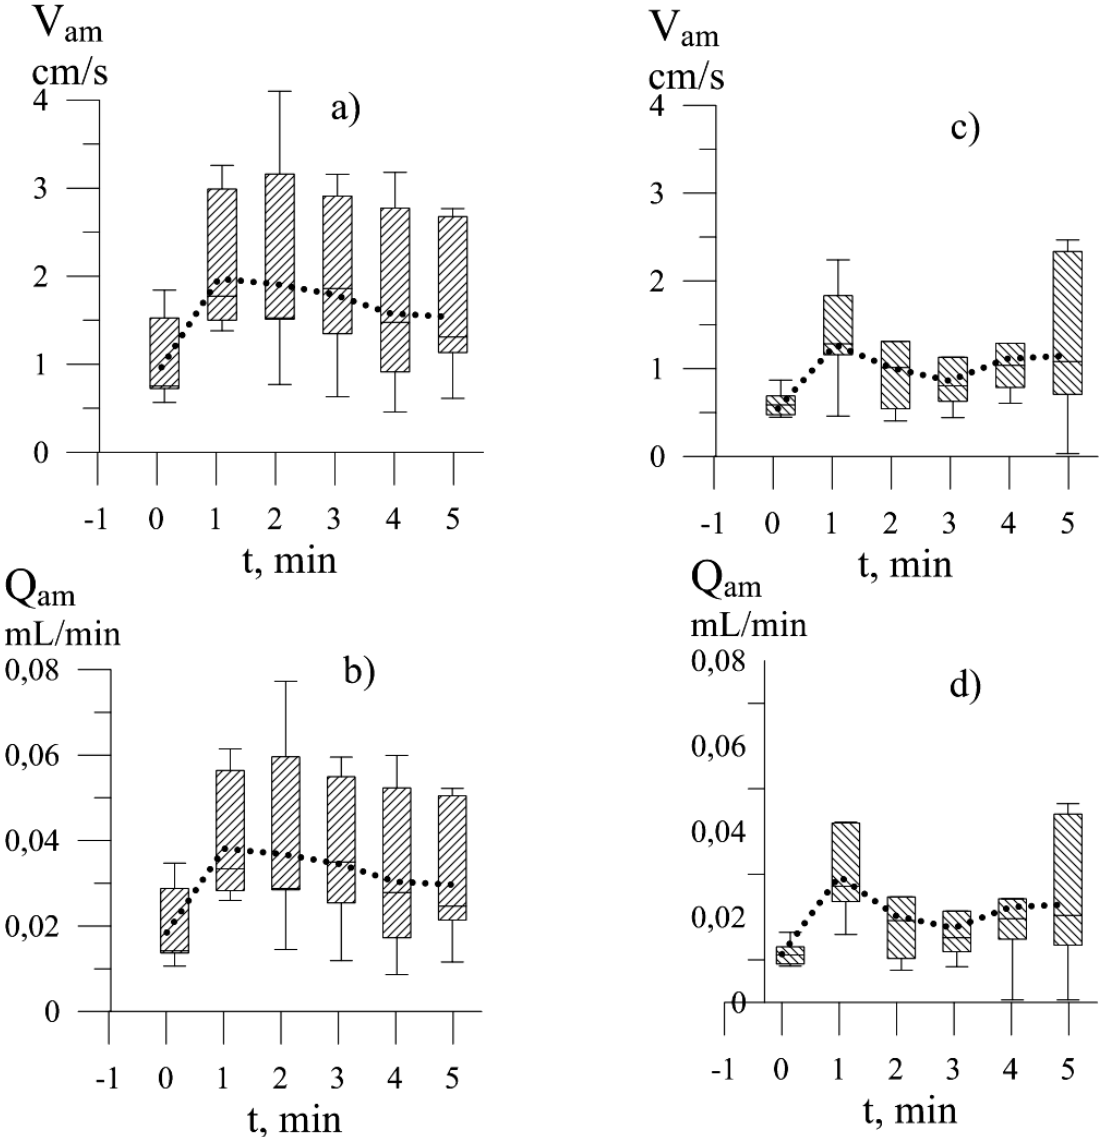
Figure 2. Values of linear ( b, d ) and volumetric ( a, c ) blood flow rates, measured USDG device: a, c - left hand ; b, d - right